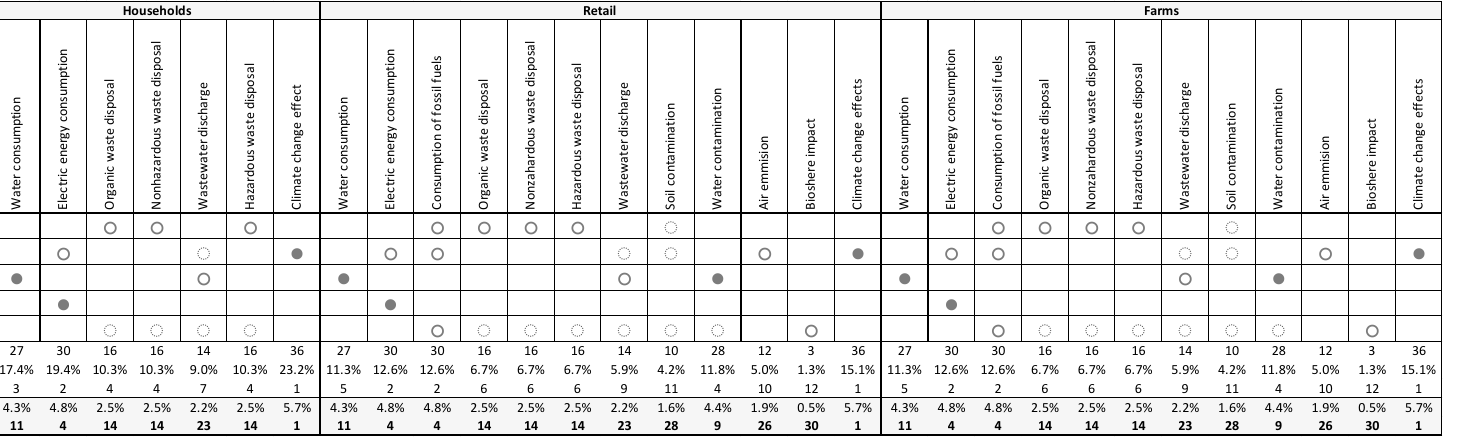
Figure 4. Environmental houses of quality (HOQ) in the egg chain; Legend: UN—United Nations; SDG—Sustainable Development Goals; ● ‘strong relationship’ = 9, ○ ‘moderate’ = 3, ◌ ‘weak relationship’ = 1 and blank = ‘non-existent’ or ‘zero’.